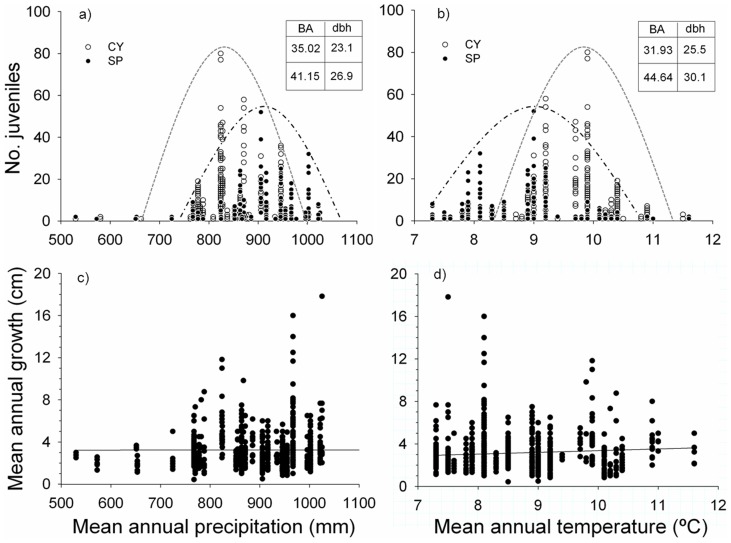
Distribution of current-year seedlings (CY) and juveniles older than a year (SP) according to a) the annual mean precipitation; and b) the mean annual temperature (with their envelope lines for each cohort).Distribution of mean growth according to c) the mean annual precipitation and d) mean annual temperature. (BA: mean basal area (m2ha−1); dbh: mean diameter at breast height (cm); both calculated within an interval around the optimum annual mean precipitation (±50 mm) and temperature (±0.5 °C), respectively).